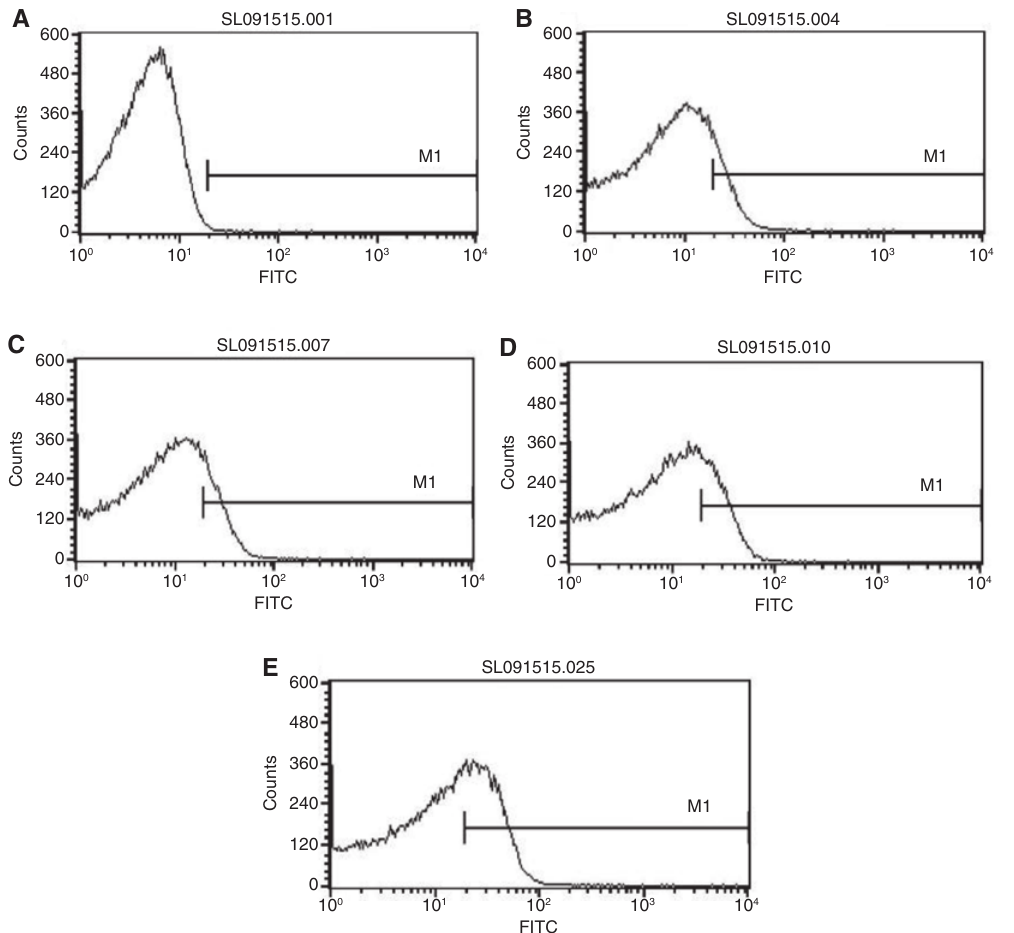
Figure 2: Representative FITC intensity histograms of the blood samples exposed to fluorescent PLGA nanoparticles at different concentra- tions for 200 nm nanoparticles, as follows: untreated blood (A) and blood exposed to nanoparticles at 2 mg/ml (B), 3 mg/ml (C), 5 mg/ml (D), and 10 mg/ml (E). M1 represents the population with specific signal over control.